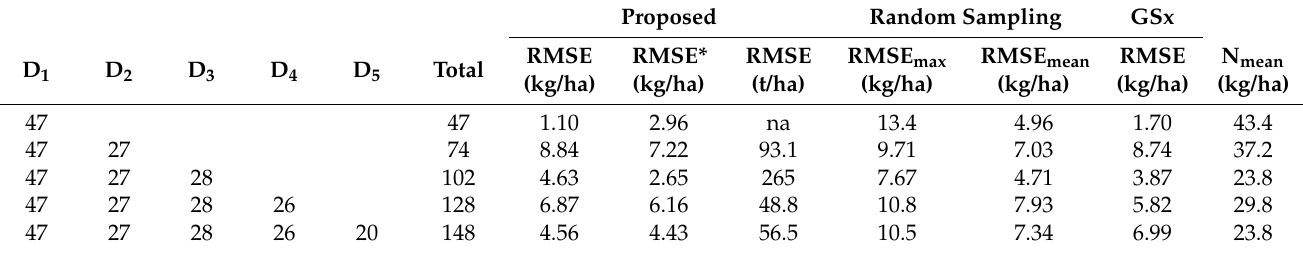
Table 3. Nitrogen content estimation results using the proposed methodology, the greedy sampling and the random sampling approaches. The first five columns express, for each date, the number of samples exploited for PLSR model calibration, with the red-framed cell indicating the prediction date. Results are expressed in terms of the root mean squared error RMSE. The values RMSE p refer to predictions made using a model calibrated with data acquired up to D i − 1 . The column named as RMSE ∗ reports values calculated on data averaged per-treatment in analogy with the study implemented in [9]. The last column of the table refers to the average nitrogen content for each